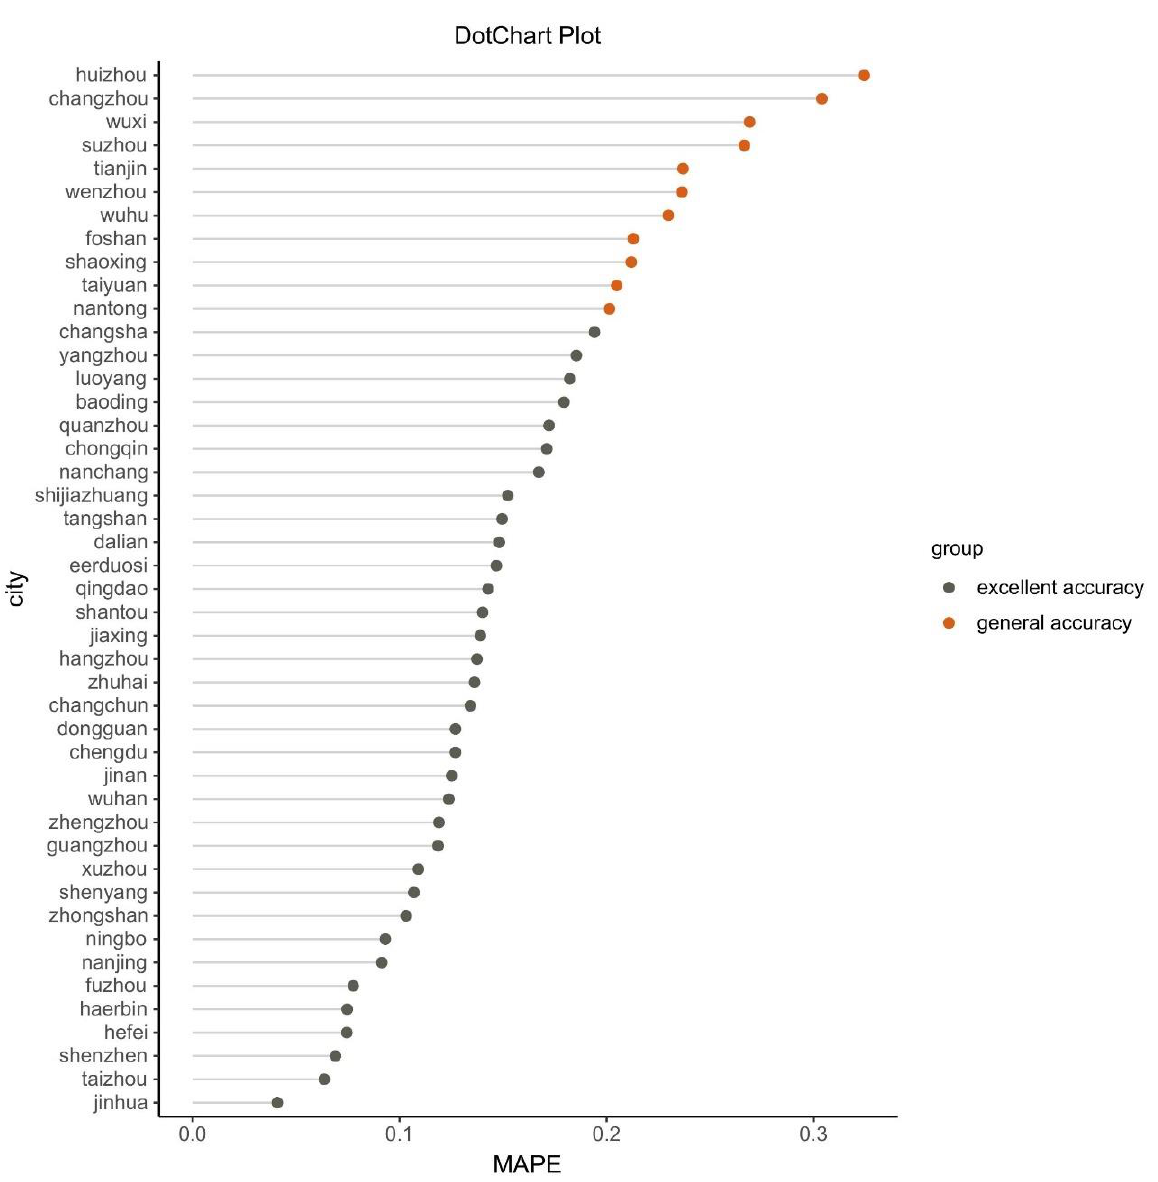
Figure A1. Mean absolute percentage error (MAPE) regression loss. MAPE can provide error assessments for the results of the random forest method for each city.